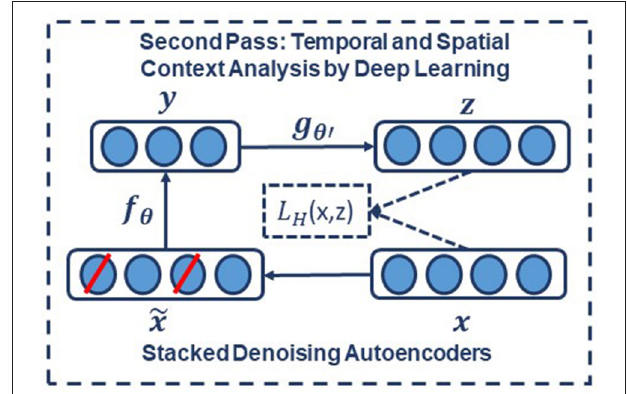
FIGURE 6 | In a stacked denoising autoencoder the input, x, is corrupted to ˜ x . The autoencoder then maps it to y and attempts to reconstructx.